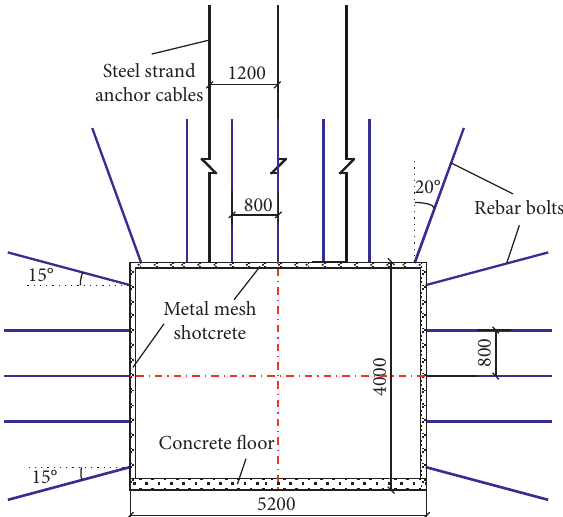
Figure 3: The support of anchor-net-cable-spraying for the south wing general return air